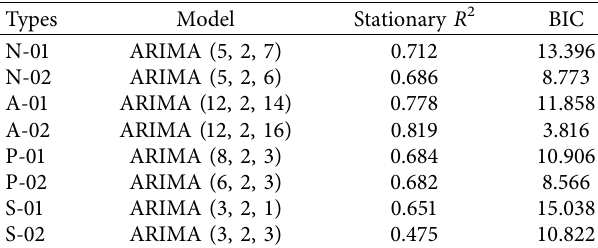
Table 5: ARIMA model test results of the topic data